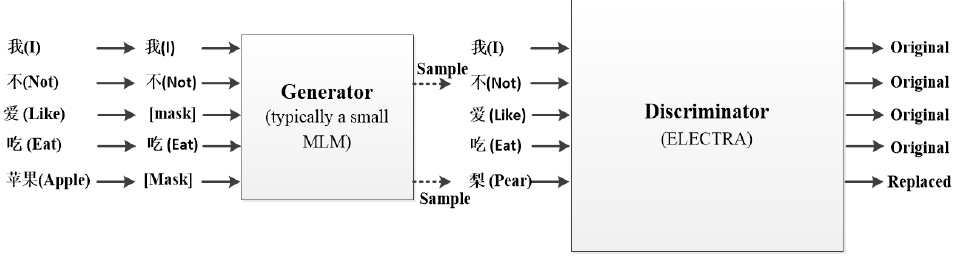
Figure 2. ELECTRA architecture overview.